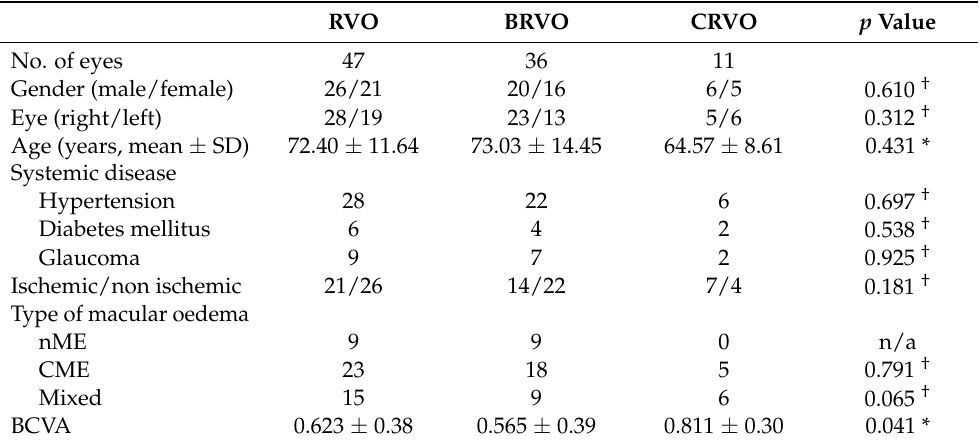
Table 1. Patient demographics and clinical characteristics in subjects with recent-onset retinal vein occlusion.